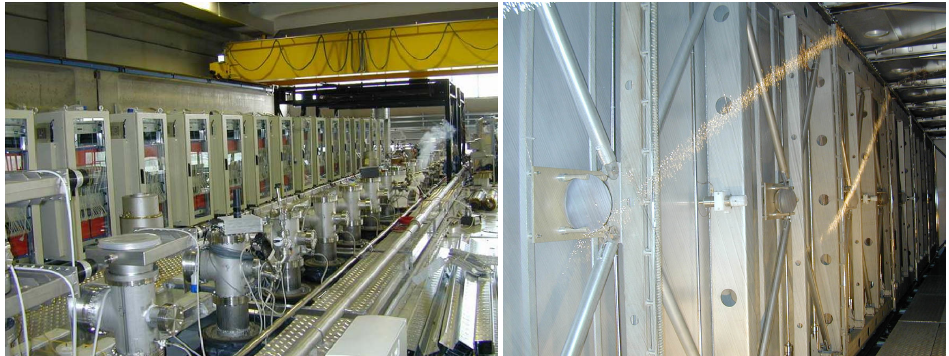
Figure 6. ( Left ): Top of one module of ICARUS-T600 in the Pavia surface laboratory, showing the disposition of the electronic racks for the one TPC and of the chimneys with the feed-through flanges for the other TPC. ( Right ): Inner detector of one module of ICARUS-T600, showing the wire chamber structure and the PMTs